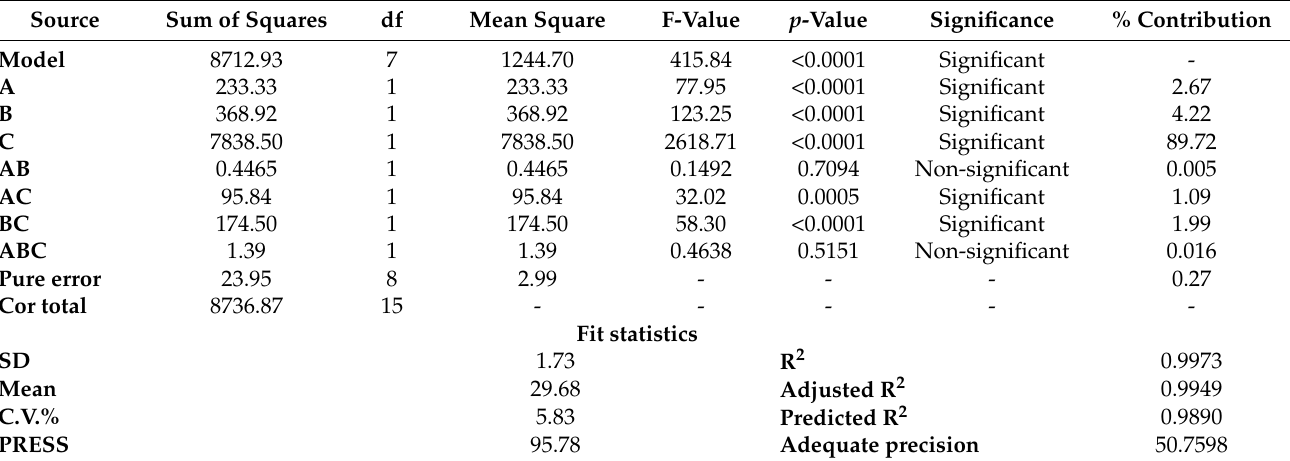
Table 5. Results of ANOVA statistical analysis of Y 1